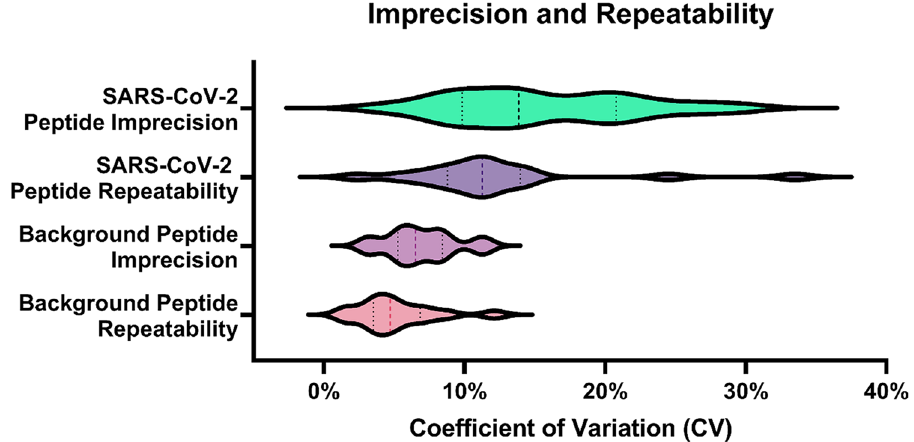
Figure 5. Targeted method imprecision (repeated preparations of pooled sample, n = 5) and repeatability (repeated injections of pooled sample extract, n = 6). Results are combined for 6 SARS-Cov-2 peptides using CVs for peak area, IS peak area and peak area ratio, and for 6 background peptides for peak area